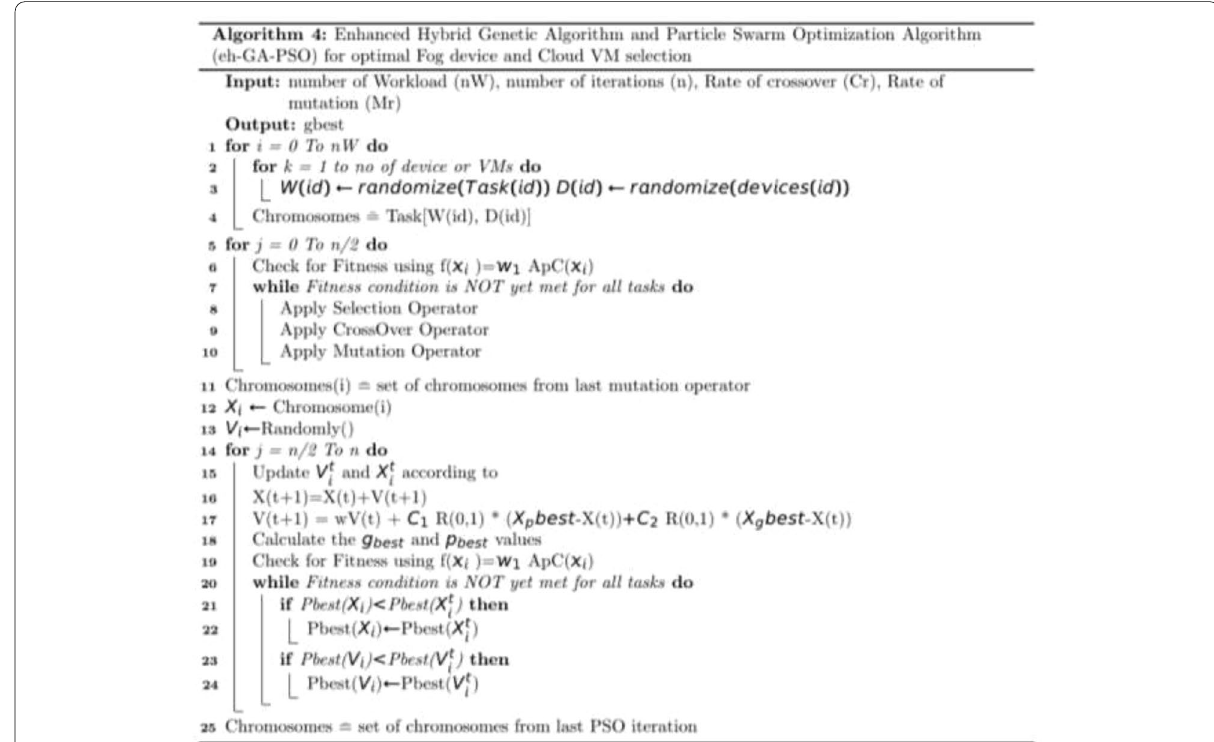
Fig. 6 Enhanced hybrid Genetic Algorithm and Particle Swarm Optimization Algorithm